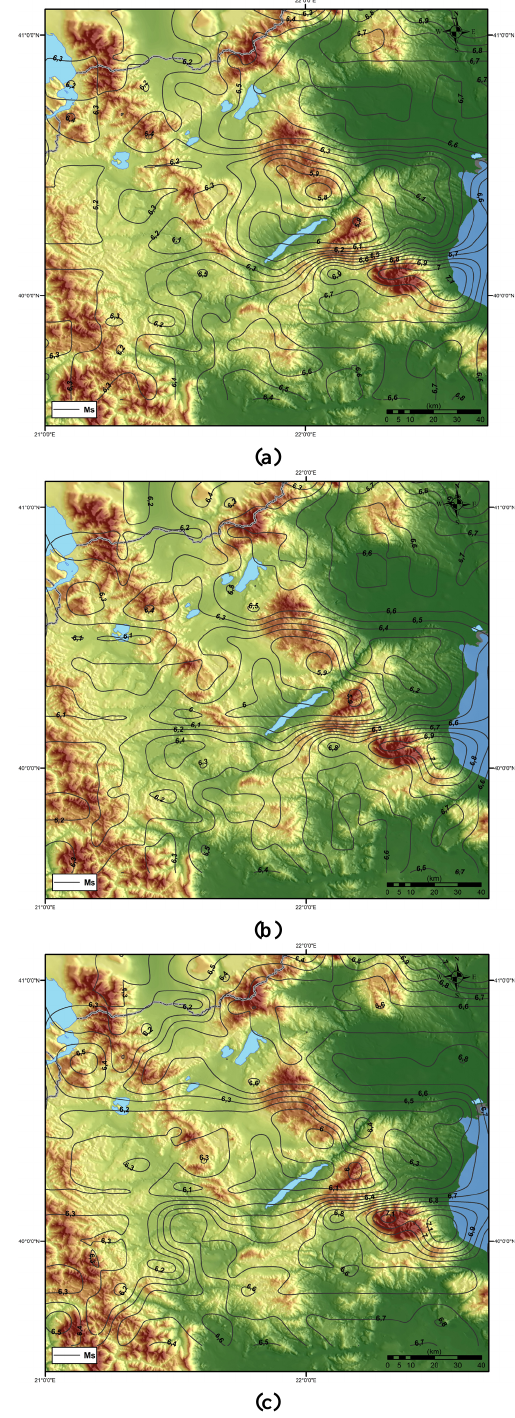
Fig. 8. (a) The 50-yr most-probable maximum earthquake magni- tude for the period: 1900–1973. (b) The 50-yr most-probable maxi- mum earthquake magnitude for the period: 1900–1994. (c) The 50- yr most-probable maximum earthquake magnitude for the period: